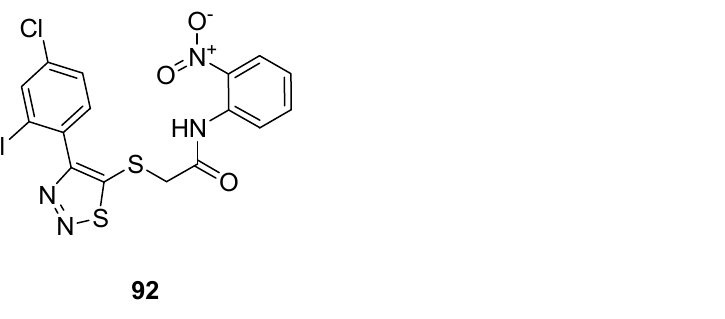
Figure 4. Thioacetanilide based 1,2,3-thiadiazole scaffold 92 exhibiting maximum anti-HIV poten- tial.